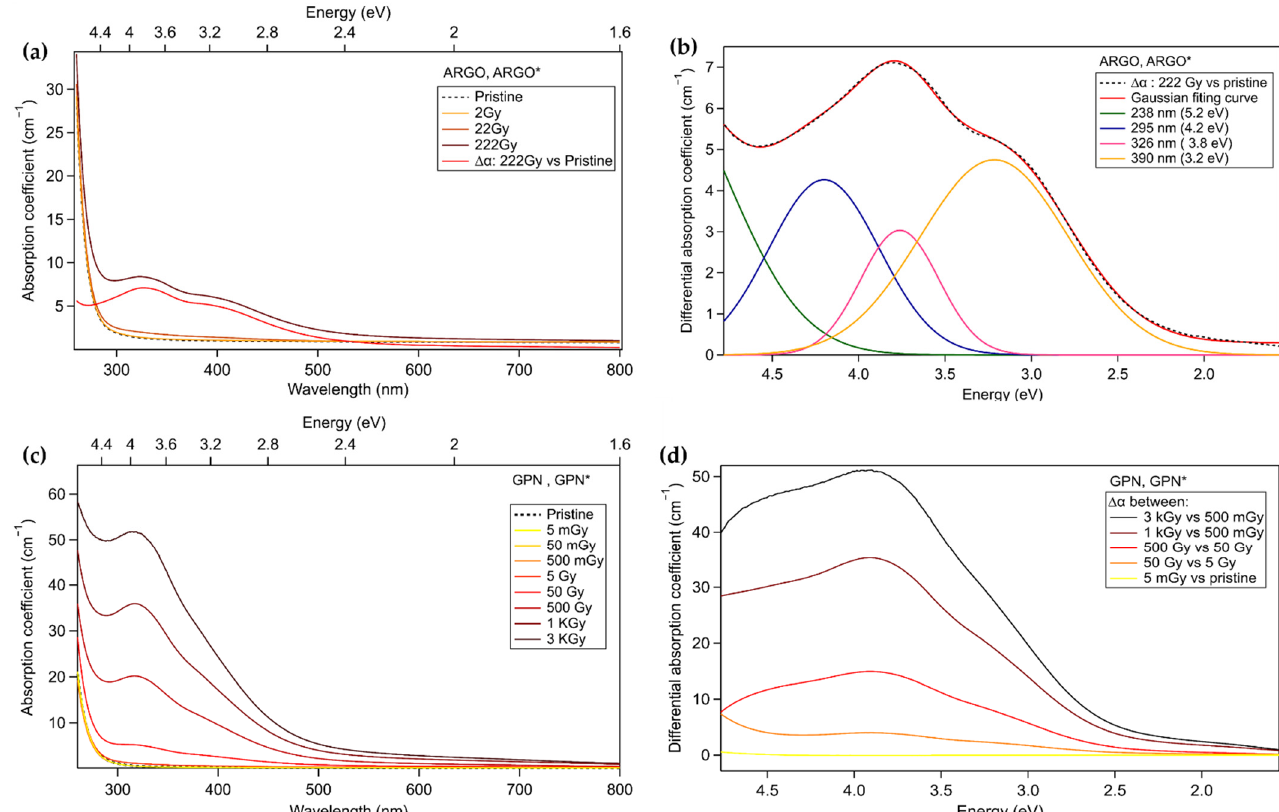
Figure 3. ( a ) Absorption spectra of the ARGO and ARGO* glass sample after various X-ray doses and the difference absorption coefficient spectrum for 222 Gy vs. pristine. ( b ) Fit of the radiation-induced spectrum (difference between 222 Gy and pristine) considering Gaussian energy contributions for ARGO and ARGO*. ( c ) Absorption spectra for the GPN and GPN* glasses for X-ray doses from 5 mGy to 3 kGy [39]. ( d ) The difference absorption coefficient spectra between different doses conditions for GPN and GPN* [39].